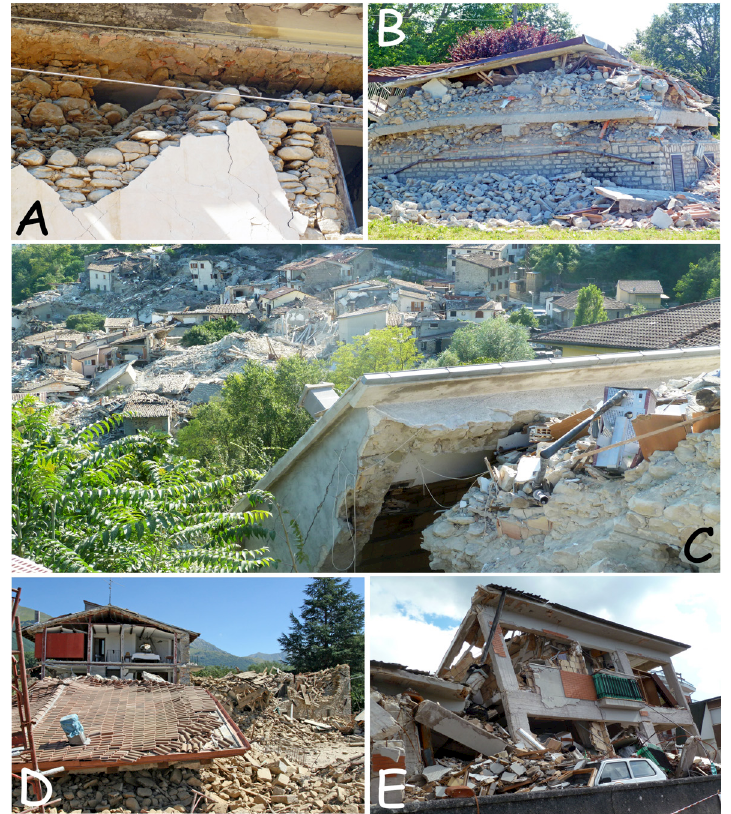
Figure 1. A, Rounded, fluvial cobbles masonry in Sommati (Amatrice). B, Collapse of a stone masonry building with RC ring beans (San Lorenzo e Flaviano, Amatrice). C, Crashed RC roof over a stone masonry house; in the background, view of the destroyed village of Pescara del Tronto (10-11 MCS). D, Collapse of stone masonry house in Petrana; behind, note the part of the same building added interiorly with a steel moment-resisting frame. E, Collapse of a RC building in